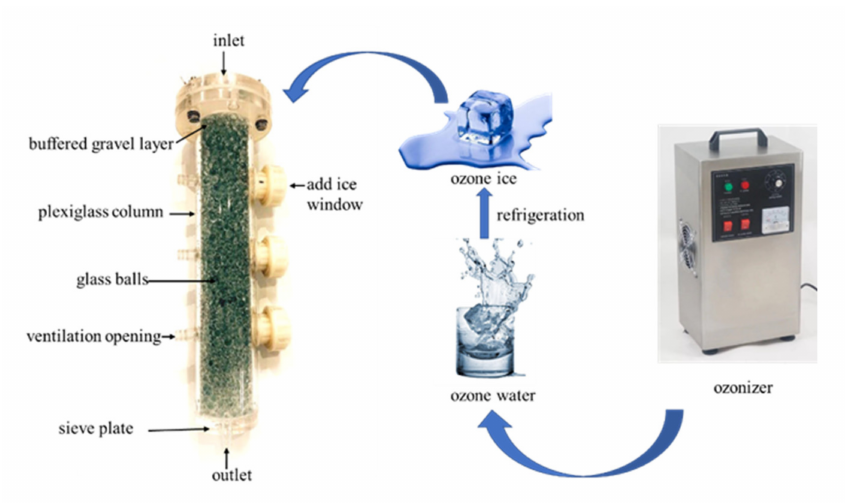
Figure 5. Experimental column leaching apparatus